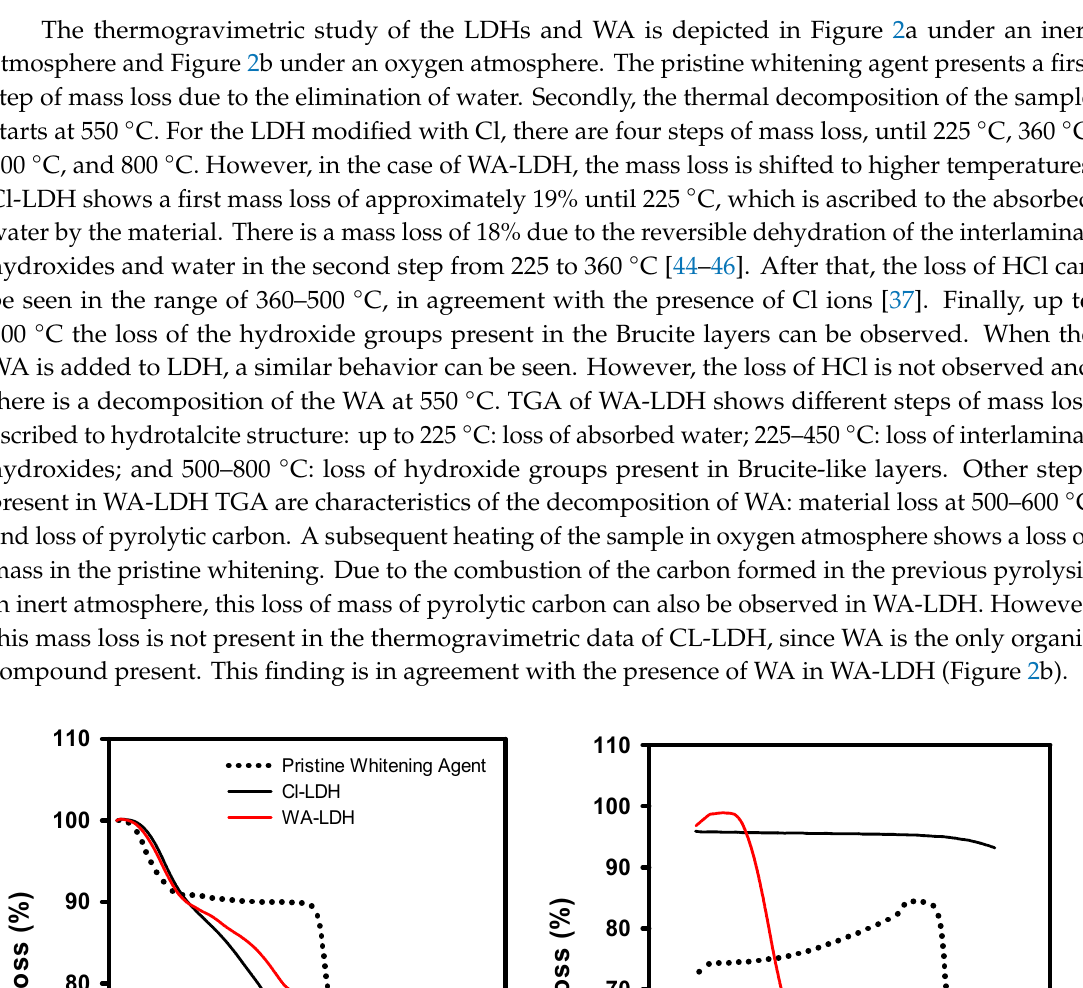
Table 3. Infrared bands observed for unmodified LDH, Cl-LDH, and WA-LDH compared to the literature data.